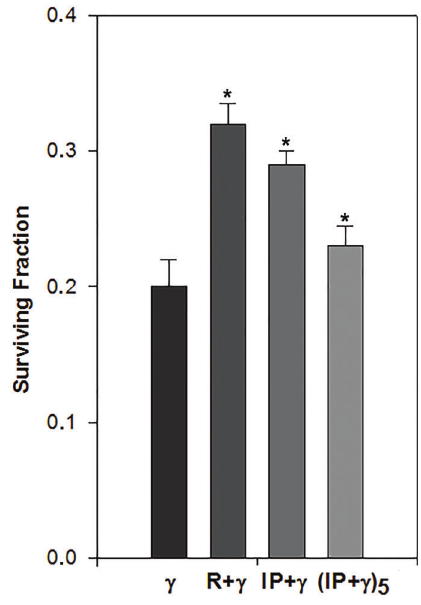
Figure 2. Surviving fractions of wildtype SC7K lys2-3 cell samples exposed to gamma rays or to indicated combinations. g : gamma ray of D=200 Gy; R + g : rutin added 1 h before irradia- tion; Ip + g : Ilex paraguariensis added 1 h before irradiation; (Ip + g ) 5 : Ilex paraguariensis added 5 min before irradiation. Data from at least three reproducible experiments are reported as means ± SD. *P p 0.05 (binomial